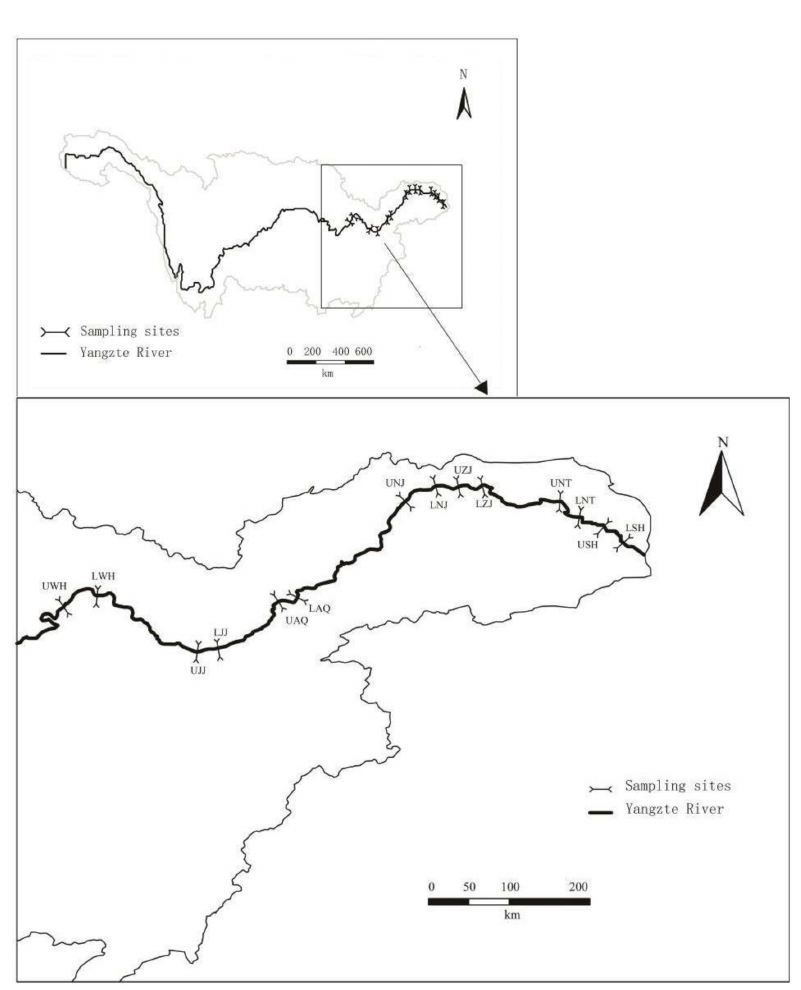
Figure 1. Location of sampling sites along the middle and lower reaches of the Yangtze